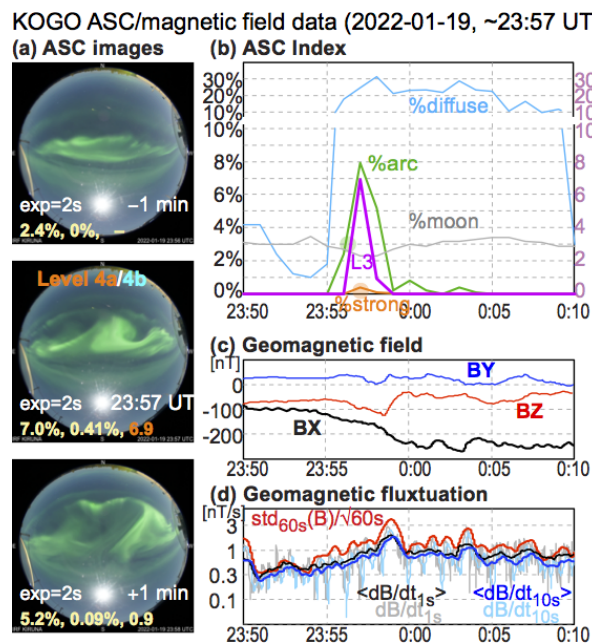
Figure 11. The same as Fig. 8 for the Level 4a/b auroral activity at 23:57UT on 19 January 2022.